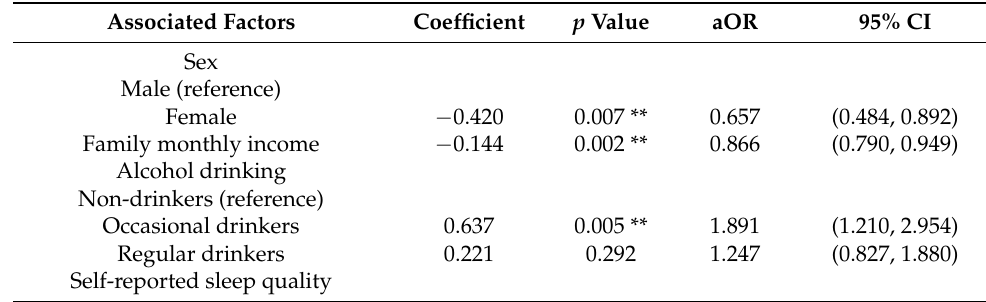
Table 3. Associated factors of using electronic devices before